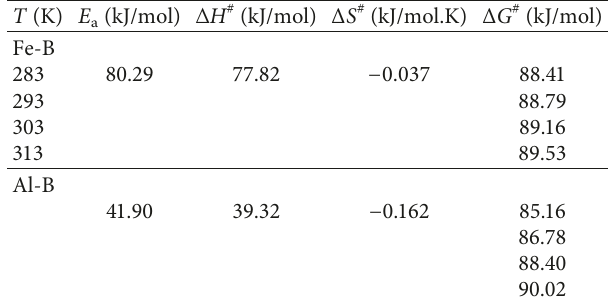
Table 4: Activation energy and activation parameters of adsorption